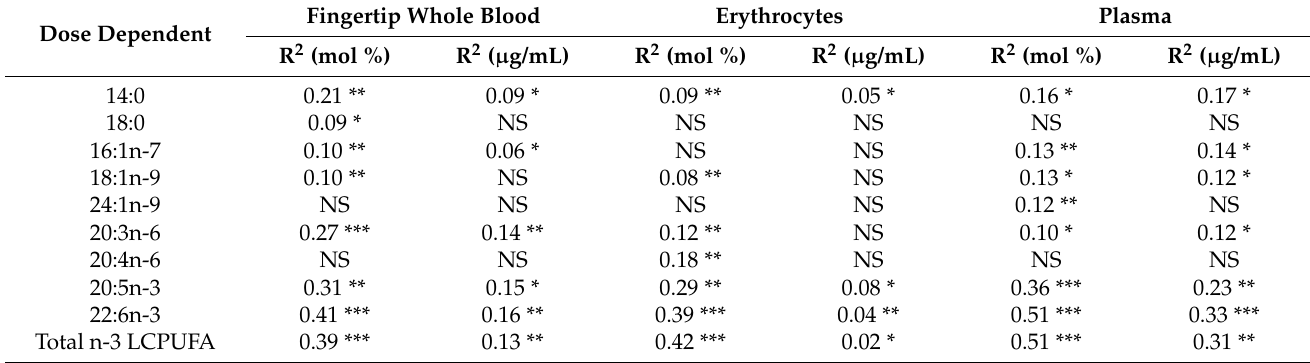
Table 3. Coefficient of determination (R 2 ) for fingertip whole blood, erythrocyte and total plasma fatty acids where dose was a significant predictor of post-intervention fatty acid levels (expressed as mol % or µ g/mL blood; n = 49 for fingertip whole blood, n = 53 for plasma and